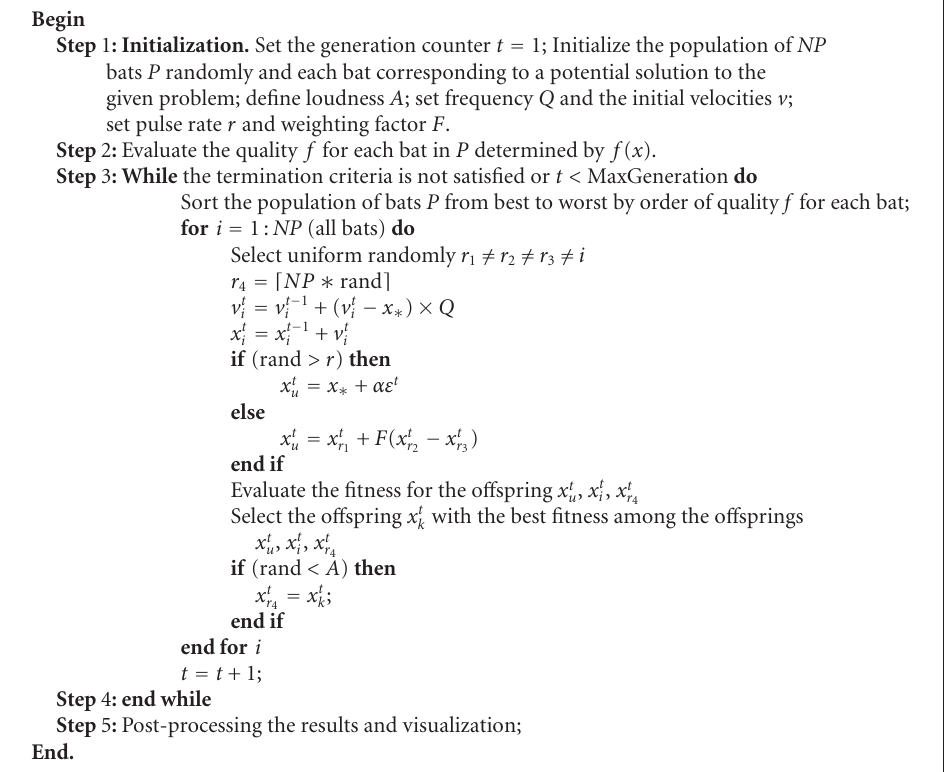
Algorithm 3: Bat algorithm with mutation.